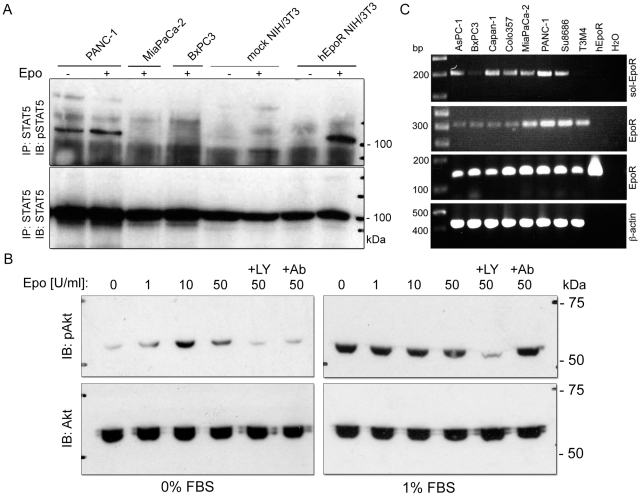
Activation of PI3K/Akt but not Jak2/STAT5 signaling in PDAC cells exposed to Epo.(A) Phosphorylation status of Stat5 was assessed in serum-starved pancreatic tumor cells and hEpoR-transduced NIH/3T3 cells stimulated with 50 U/ml erythropoietin (Epo) for 10 min. Clear accumulation of pSTAT5 was observed in hEpoR-NIH/3T3 but not in mock-transduced NIH/3T3 cells or in PDAC cells, independent of the level of constitutive pSTAT5 activation. (B) Phosphorylation status of Akt was assessed in serum-starved (left panel) or non-starved (right panel) PANC-1 cells consequently stimulated with Epo at 0–50 U/ml for 15 min. Epo-enhanced pAkt phosporylation was detected only under conditions of serum starvation and could be specifically inhibited by anti-EpoR antibody (+Ab) or phosphatidylinositol-3-OH kinase (PI3K) inhibitor LY2940020 (+LY). (C) Accumulation of mRNA coding for soluble EpoR isoform (upper panel; primers: EpoR_S5/6, table 2) as compared to mRNAs coding for full-length isoforms (two middle panels) and further related to expression of ß-actin (lower panel). 3′-end-based detection of EpoR mRNA was performed with antisense primers binding after (EpoR_FL1/2) or prior to a stop codon (EpoR_FL3/4) as visualized by a hEpoR plasmid carrying only the coding sequence for a full-length isoform.